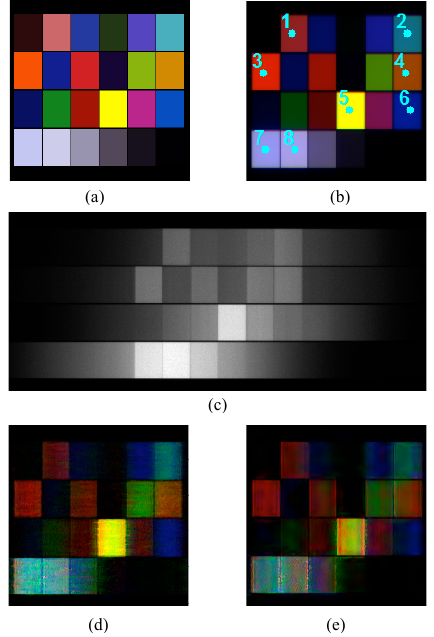
Figure 3. Object "color checker" with the 33 spectral bands in the range of 400nm-720nm: (a) iPad object; (b) reference spectral cube directly measured with 33 spectral filters and converted to RGB format; (c) dispersed and diffused (DD) image optically recorded at the image sensor; (d), (e), reconstructed spectral cubes converted to RGB format, obtained with 2D framelet and 3D wavelet methods, respectively. The calculated PSNR (RMSE values in brackets) values of the spectral cubes obtained with the 2D framelet reconstruction method are 26.13 (0.05), and for the 3D wavelet reconstruction method are 28.38 (0.038). For the RGB images, the calculated PSNR RGB (RMSE RGB values in brackets) values of the obtained with the 2D framelet reconstruction method are 17.67 (0.049), and for the 3D wavelet reconstruction method are 15.92 (0.16). Figure 4 shows five out of 33 monochromatic images extracted from the spectral cubes at wavelengths 450 nm, 540 nm, 570 nm, 610 nm and 650 nm. Figure 4(a) shows the original, Figures 4(b) and 4(c) and show the images that correspond the 2D framelet reconstruction and 3D wavelet reconstruction methods, respectively. Figure 4(d) shows the RMSE λ values per wavelength, while Figure 4(e) shows the PSNR λ values per wavelength, for the monochromatic images obtained with the 2D framelet (blue) and 3D wavelet (dashed green) reconstruction